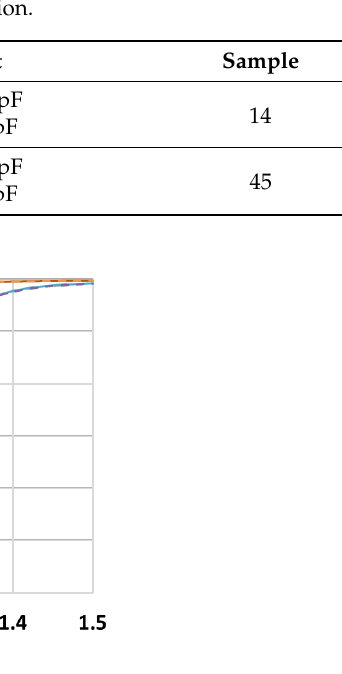
Figure 7. Comparison of results from ground truth and DNN output. Table 4. Capacitor values obtained from DNN for ideal inputs.